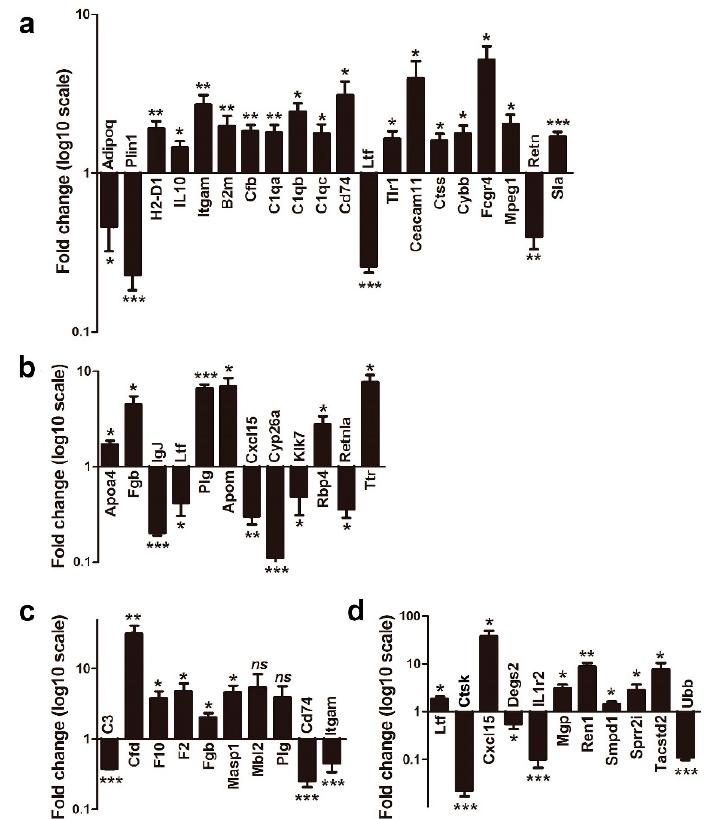
Figure 4. RT-qPCR of selected DEGs involved in clustered immune system processes: ( a ) DEGs between CpG ODN and control ODN treatments in WT mice; ( b ) DEGs between CpG ODN and control ODN treatments in NOD mice; ( c ) DEGs between WT and NOD mice with CpG ODN treatment; and ( d ) DEGs between WT and NOD mice with control ODN treatment. qRT-PCR was performed with RNA from another six individual mice in each group as biological replicates. Each sample was run in triplicate reactions as technical replicates. The value on the y -axis represents the fold change value for each gene. Data represent means of the biological replicates ± SEM ( n = 6); unpaired Student’s t -test: * p < 0.05; ** p < 0.01; *** p < 0.001; ns , not significant.